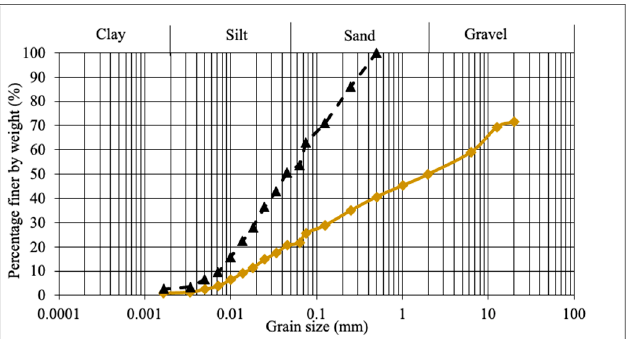
Figure 1. Grain size distribution. ( — ) original collected samples. ( - - ) tested samples obtained from the original samples after separating the grain fraction larger than 0.5 mm.